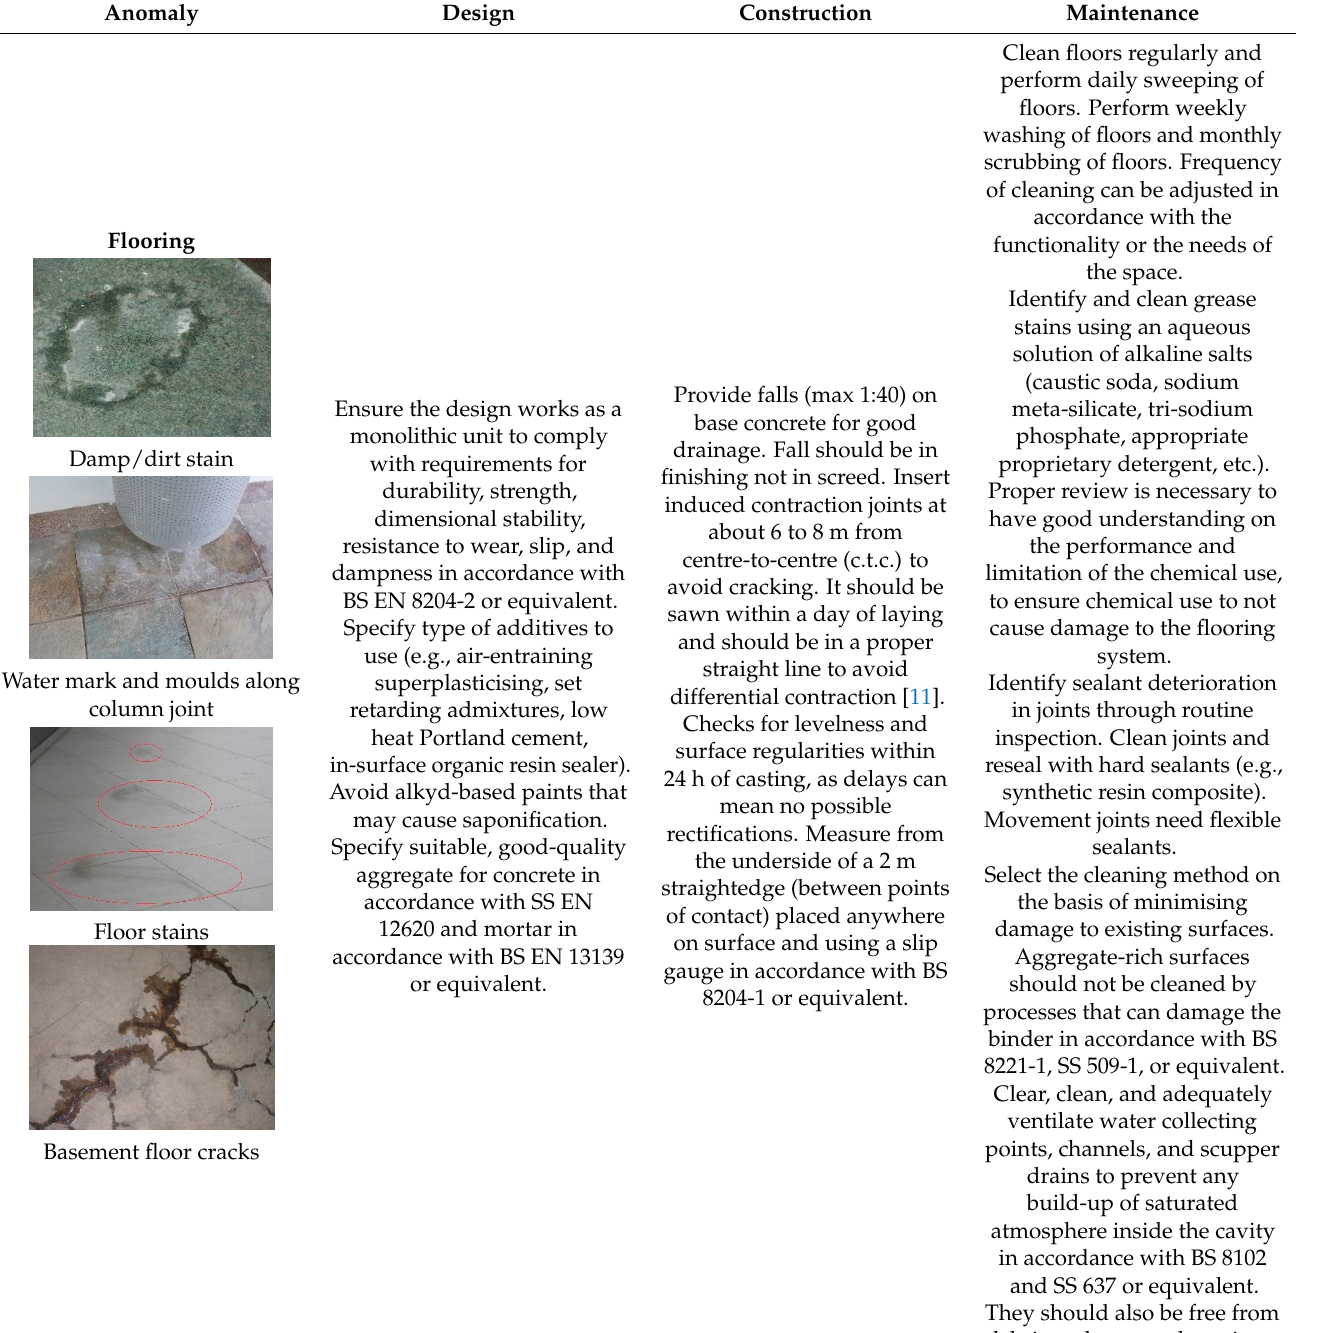
Table 4. Basements—Service components that include vertical and horizontal circulation systems, electro-mechanical connections, and sanitary